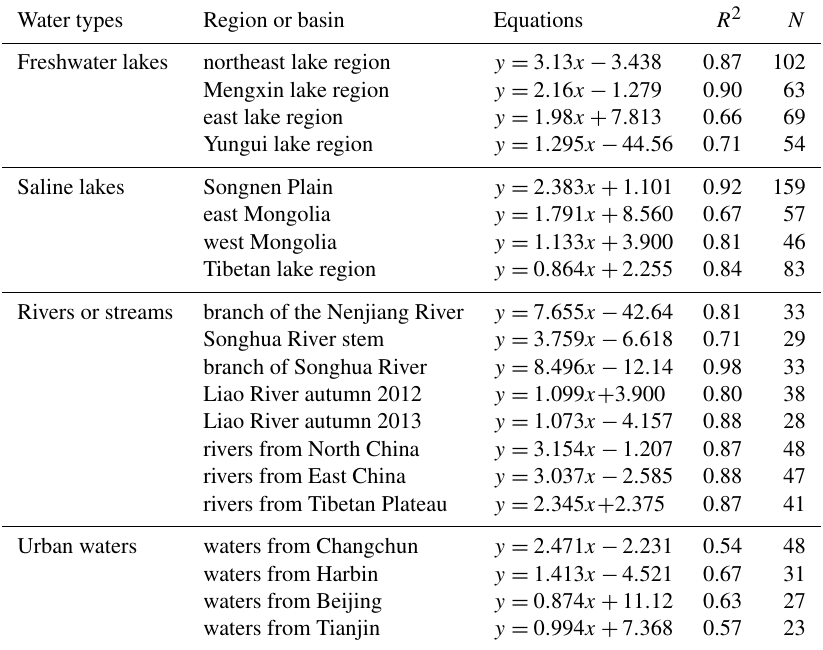
Table 3. Fitting equations for DOC vs. a CDOM (275) in different types of waters (except ice-covered lake underlying water and ice-melting